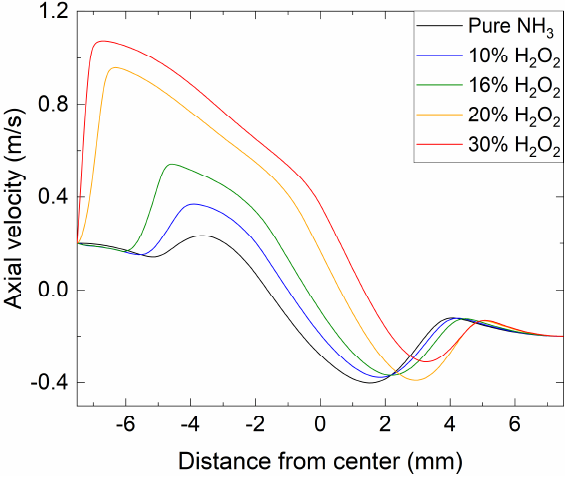
Figure 3. Axial velocity along the centerline as a function of spatial location and H 2 O 2 content in the fuel stream.